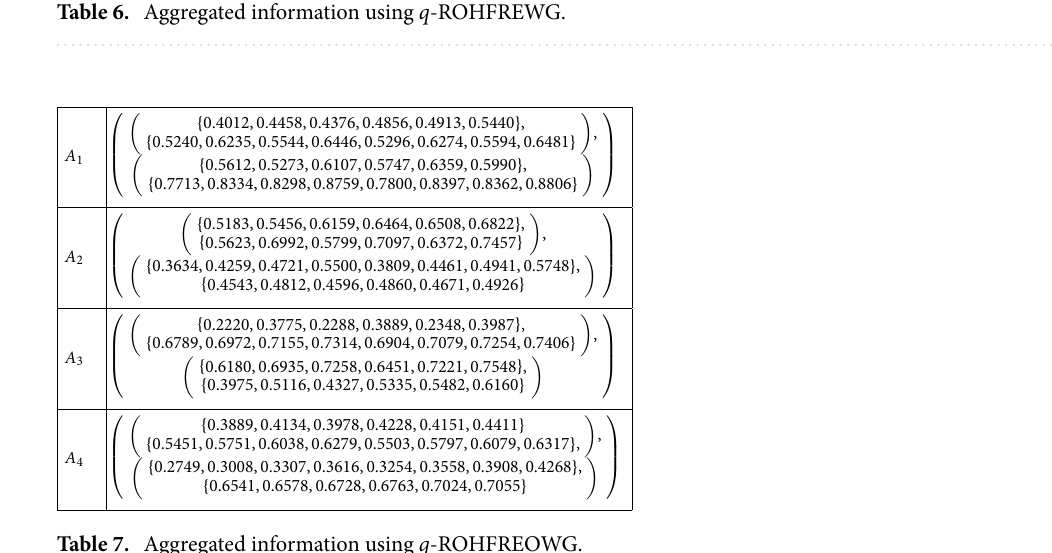
Table 7. Aggregated information using q